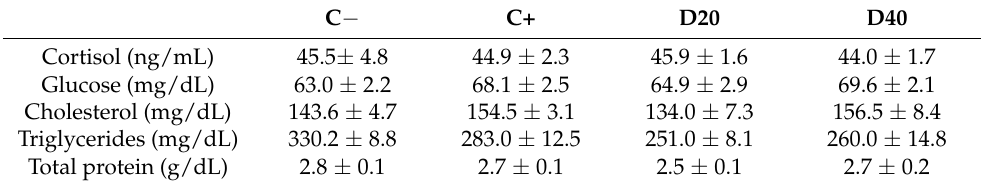
Table 4. Blood metabolites of Nile tilapia ( O. niloticus ) fed for 80 days under low-density conditions. C − C+ D20 D40 Cortisol (ng/mL) 45.5 ± 4.8 44.9 ± 2.3 45.9 ± 1.6 44.0 ± 1.7 Glucose (mg/dL) 63.0 ± 2.2 68.1 ± 2.5 64.9 ± 2.9 69.6 ± 2.1 Cholesterol (mg/dL) 143.6 ± 4.7 154.5 ± 3.1 134.0 ± 7.3 156.5 ± 8.4 Triglycerides (mg/dL) 330.2 ± 8.8 283.0 ± 12.5 251.0 ± 8.1 260.0 ± 14.8 Total protein (g/dL) 2.8 ± 0.1 2.7 ±